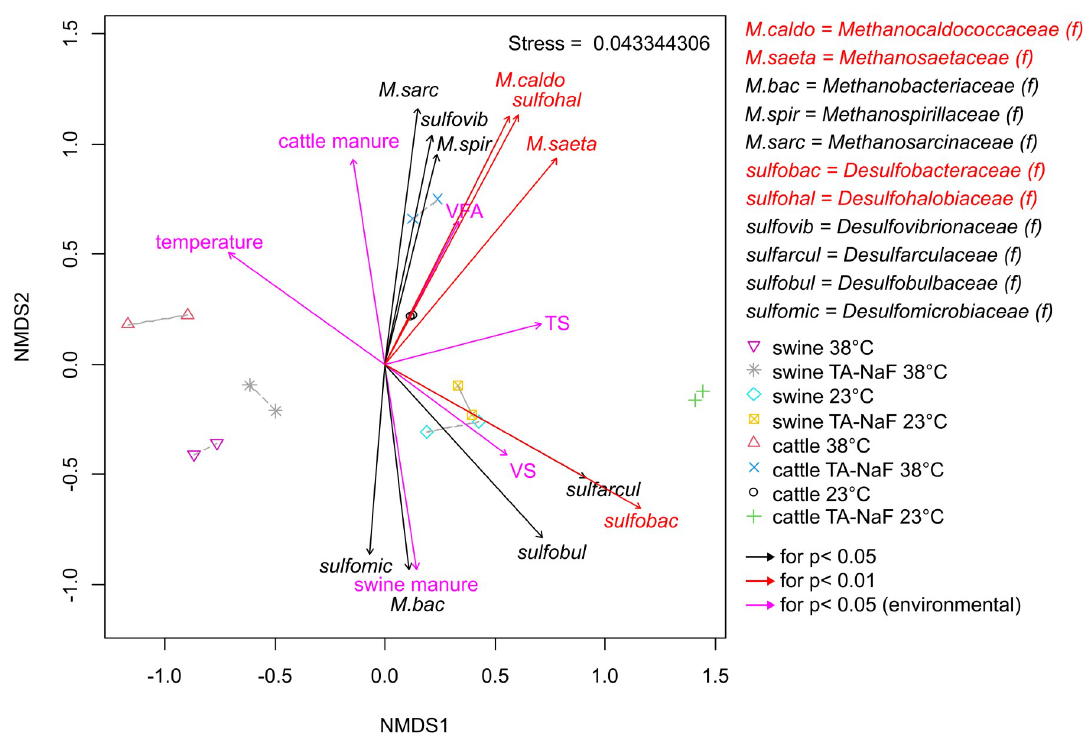
Fig 7. Non-metric multidimensional scaling of microbial community analysis and environmental parameters after 30 days of manure incubation. (f) is family taxonomy